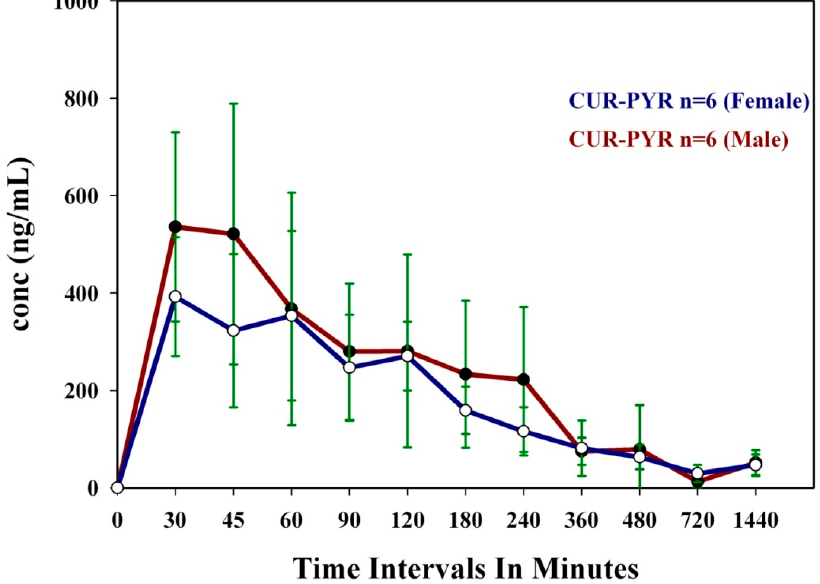
Figure 3. Mean Plasma concentration of cocrystal CUR-PYR vs. Time profile obtained from both female and male Sprague Dawley (SD) rats. Table 1. Pharmacokinetic data of Curcumin-Pyrogallol (CUR-PYR) cocrystal vs. Curcumin-Artemisinin (CUR-ART) coamorphous solids a